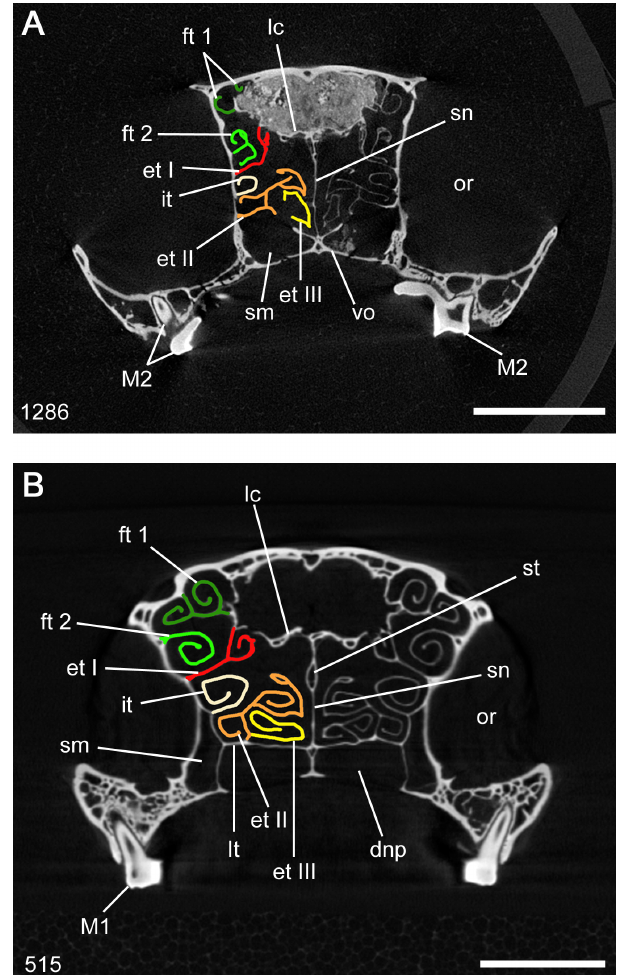
Figure 11. µCT cross-section images of the pars lateralis and pos- terior of the adult rostrum from anterior to posterior of (a) Ptilo- cercus lowii (ZMB 3992) and (b) Tupaia sp. (collection W. Maier). Numbers in figures refer to number of original µCT slices. Abbrevi- ations: dnp, ductus nasopharyngeus; et I, II, III, ethmoturbinal I, II, III; ft 1, 2, frontoturbinal 1, 2; it, interturbinal; lc, lamina